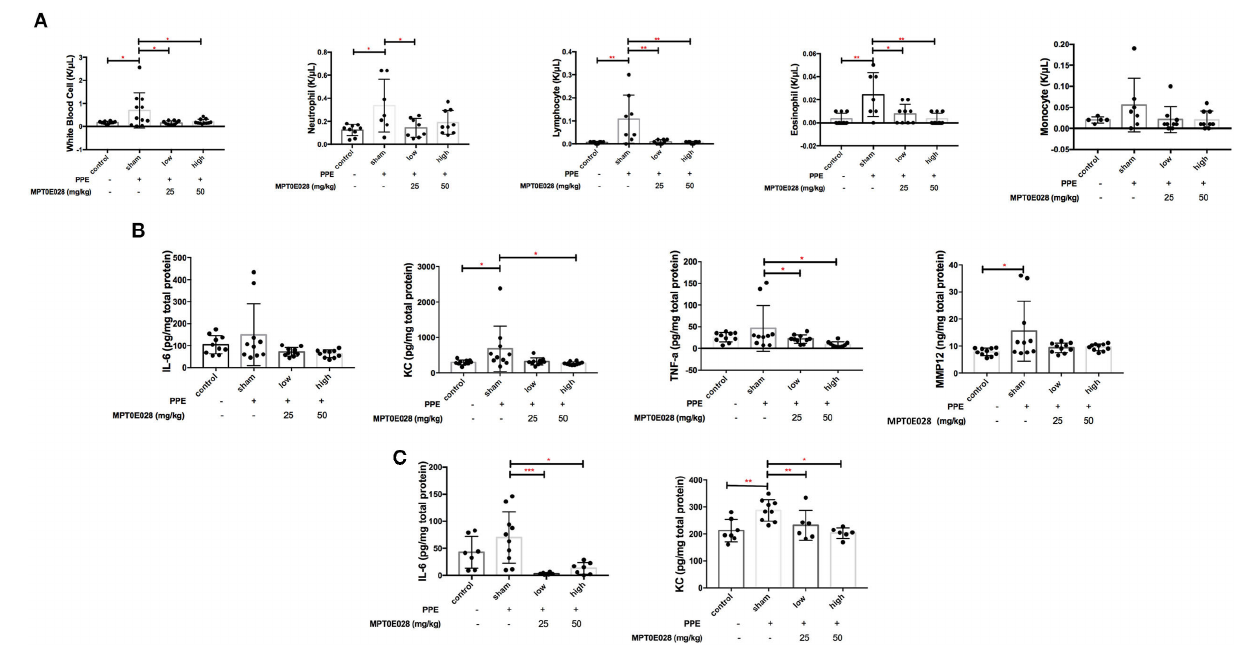
FIGURE 3 | Inflammation by the MPT0E028 in mice with porcine pancreatic elastase (PPE)-induced emphysema. (A) White blood cells, neutrophils, lymphocytes, and eosinophils in bronchoalveolar lavage fluid (BALF) by the MPT0E028 at 0, 25, and 50 mg/kg body weight (BW) ( n = 10). (B) Interleukin (IL)-6, keratinocyte-derived chemokine (KC), tumor necrosis factor (TNF)- α , and matrix metallopeptidase (MMP)-12 in lung lysates by the MPT0E028 at 0, 25, and 50 mg/kg BW ( n = 10). (C) IL-6 and KC in serum by the MPT0E028 at 0, 25, and 50 mg/kg ( n = 10). * p < 0.05; ** p <